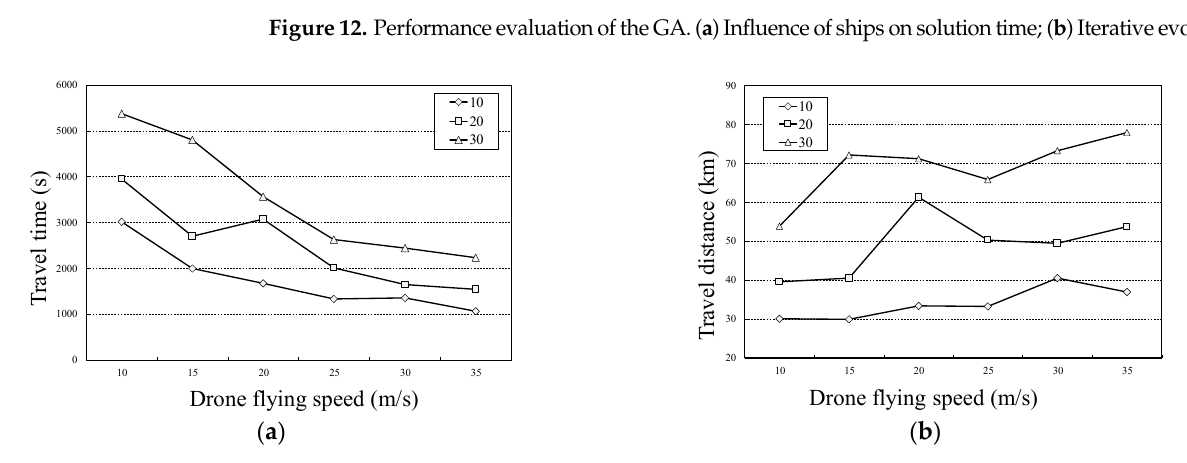
Figure 12. Performance evaluation of the GA. ( a ) Influence of ships on solution time; ( b ) Iterative evolution